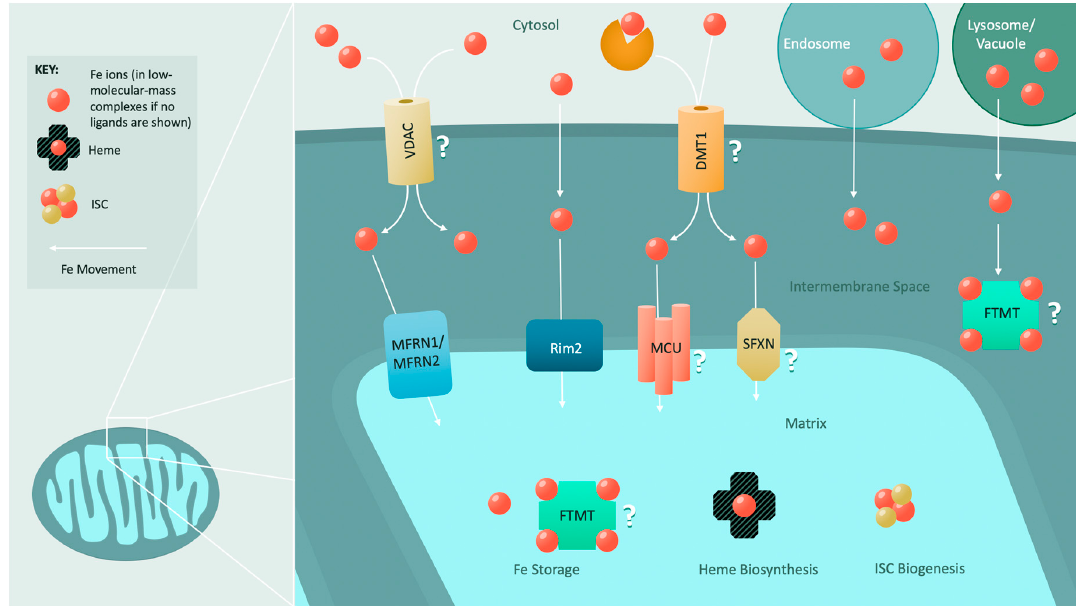
Figure 2. Mitochondrial iron import and utilization: The mechanism for iron import through the outer mitochondrial membrane is poorly understood. However, it is speculated that ion channels such as VDACs and a recently identified mitochondrial divalent metal transporter (DMT1) facilitate the import of iron. Interorganellar contacts with endosomes, lysosomes, and vacuoles can also convey iron to mitochondria. Transport across the inner mitochondrial membrane is primarily driven by the conserved mitoferrins (MFRN1 and MFRN2). In yeast, a low-affinity iron transporter (Rim2) assists the mitoferrins. Roles in inner mitochondrial membrane iron import have also been hypothesized for the mitochondrial calcium uniporter (MCU) and several members of the sideroflexin (SFXN) family. Once iron is imported into the mito- chondrion, it is utilized for heme biosynthesis or ISC biogenesis, or it is stored in mitochondrial ferritin (FTMT) or within low-molecular-mass